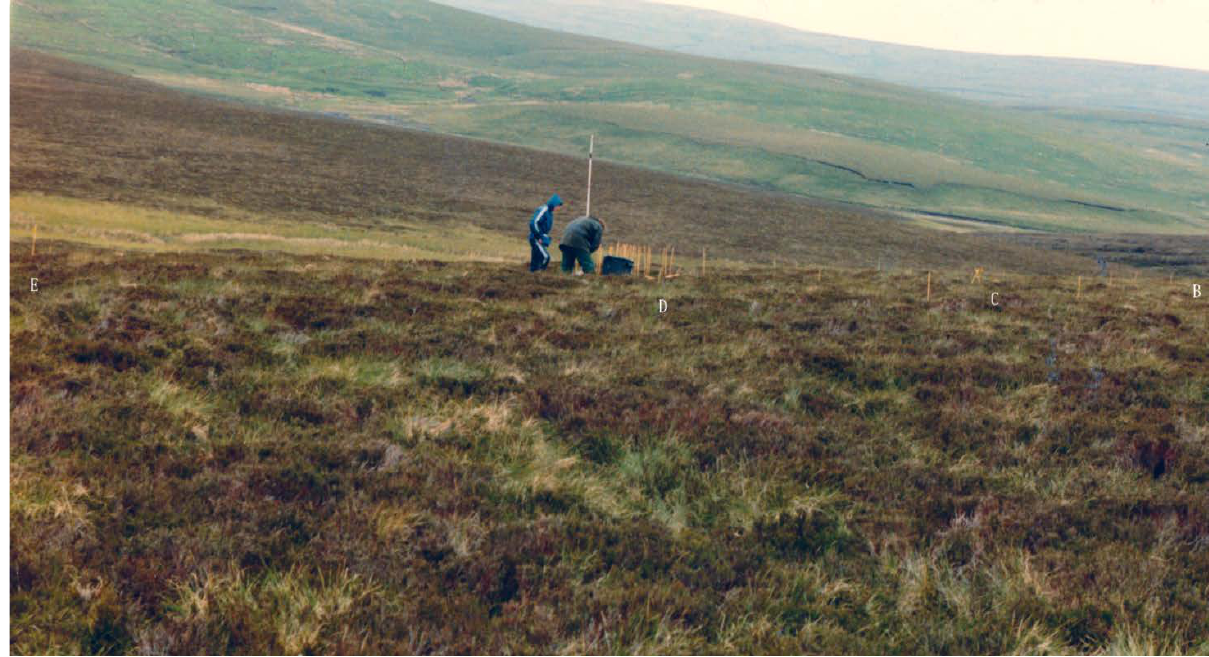
Figure 1. The experiment area, seen from the ‘level’ ground to the south of the slope, which falls away out of sight at 10 ° beyond the brow on which the injection sites were placed. The bamboo cane ‘forest’ to the right of the people (SV, BRG) marks sampling places around tritiated water injection site D. Sites B, C, D, and E are marked. The conspicuous plants are Calluna vulgaris , and some Eriophorum vaginatum .